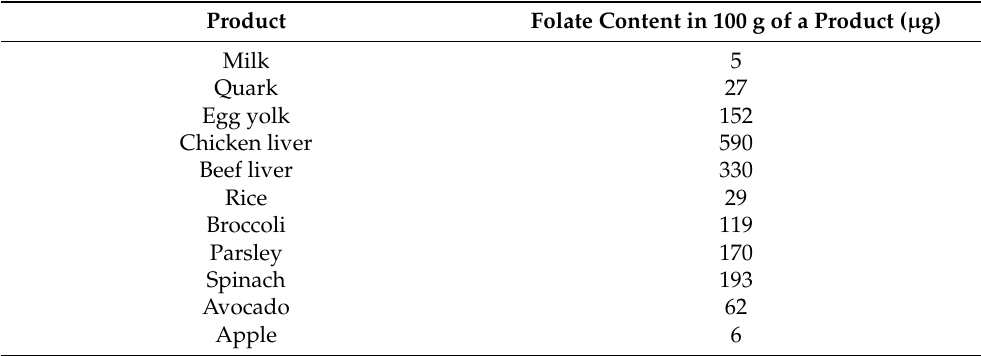
Table 1. Folate content in the selected products